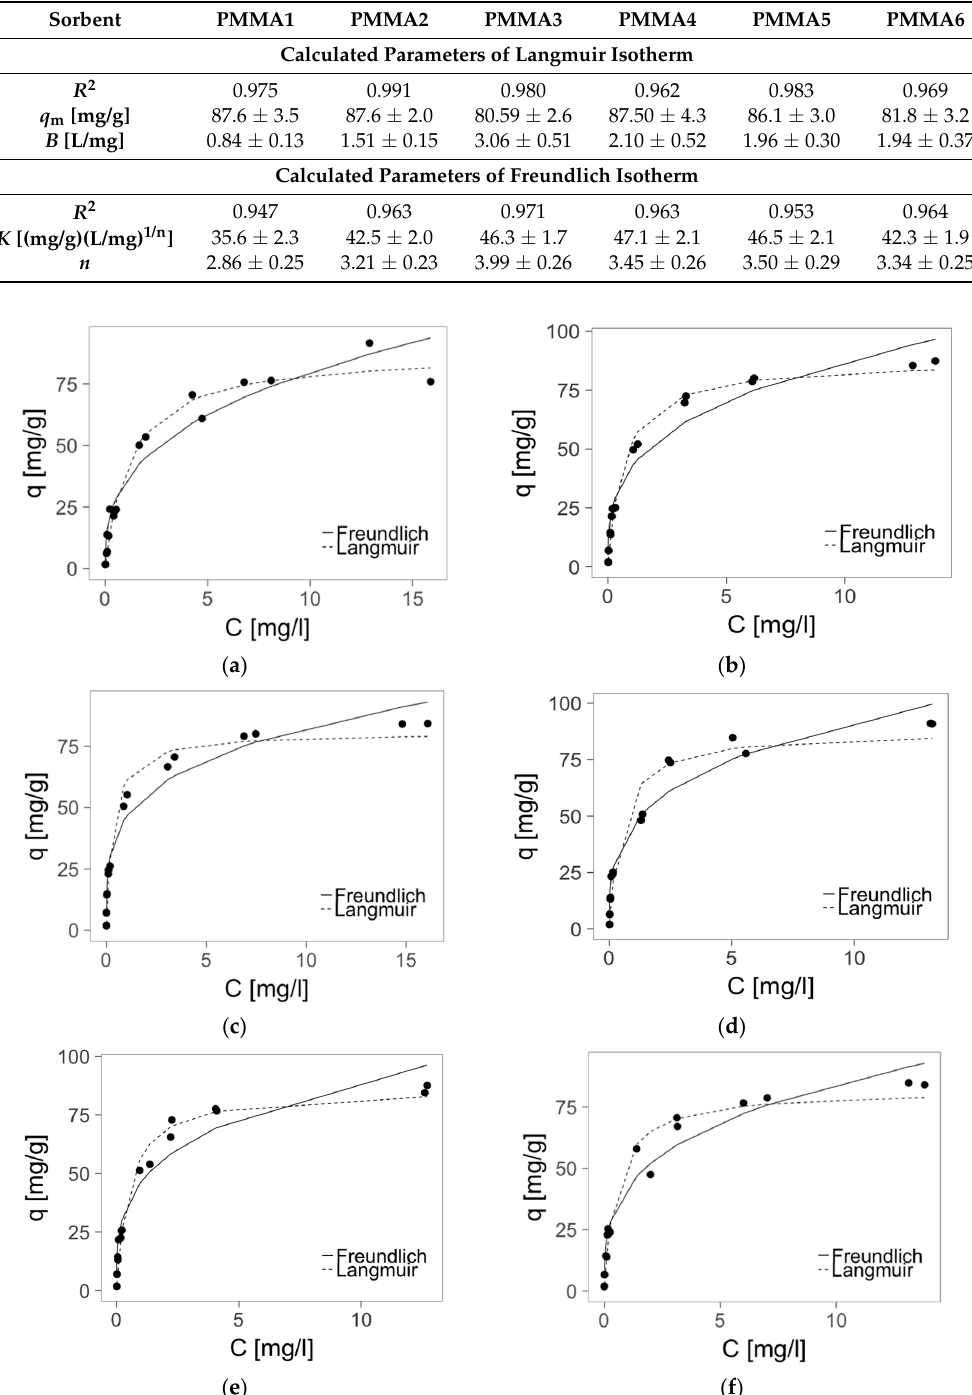
Table 3. Calculated parameters of isotherms, Langmuir and Freundlich, of Zn(II) ions sorption on PMMA-based sorbents; q m —the maximum adsorption capacity [mg/g], B —the equilibrium constant that corresponds to the adsorption energy [L/mg], K [(mg/g)(L/mg) 1/n ]—corresponds to the relative adsorption capacity, n —corresponds to the adsorption intensity of the sorbent.